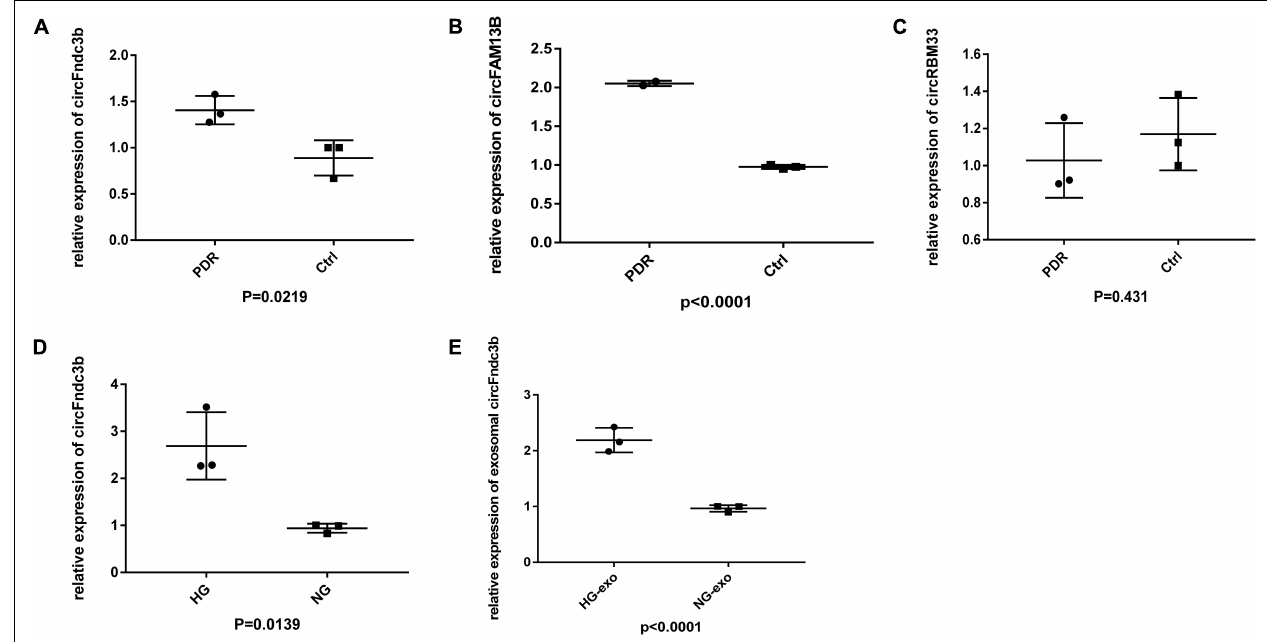
FIGURE 5 | Validation of exosomal circular RNAs (circRNAs). (A–C) Quantitative real-time PCR (qRT-PCR) verified the expressions of exosomal circFndc3b (A) , circFAM13B (B) , and circRBM33 (C) in proliferative diabetic retinopathy (PDR) and control serum exosomes. (D,E) Expression of circFndc3b on the high-glucose (HG) and negative control (NG) conditions at the cellular (D) and exosomal (E) levels in human retinal vascular endothelial cells (HRVECs).